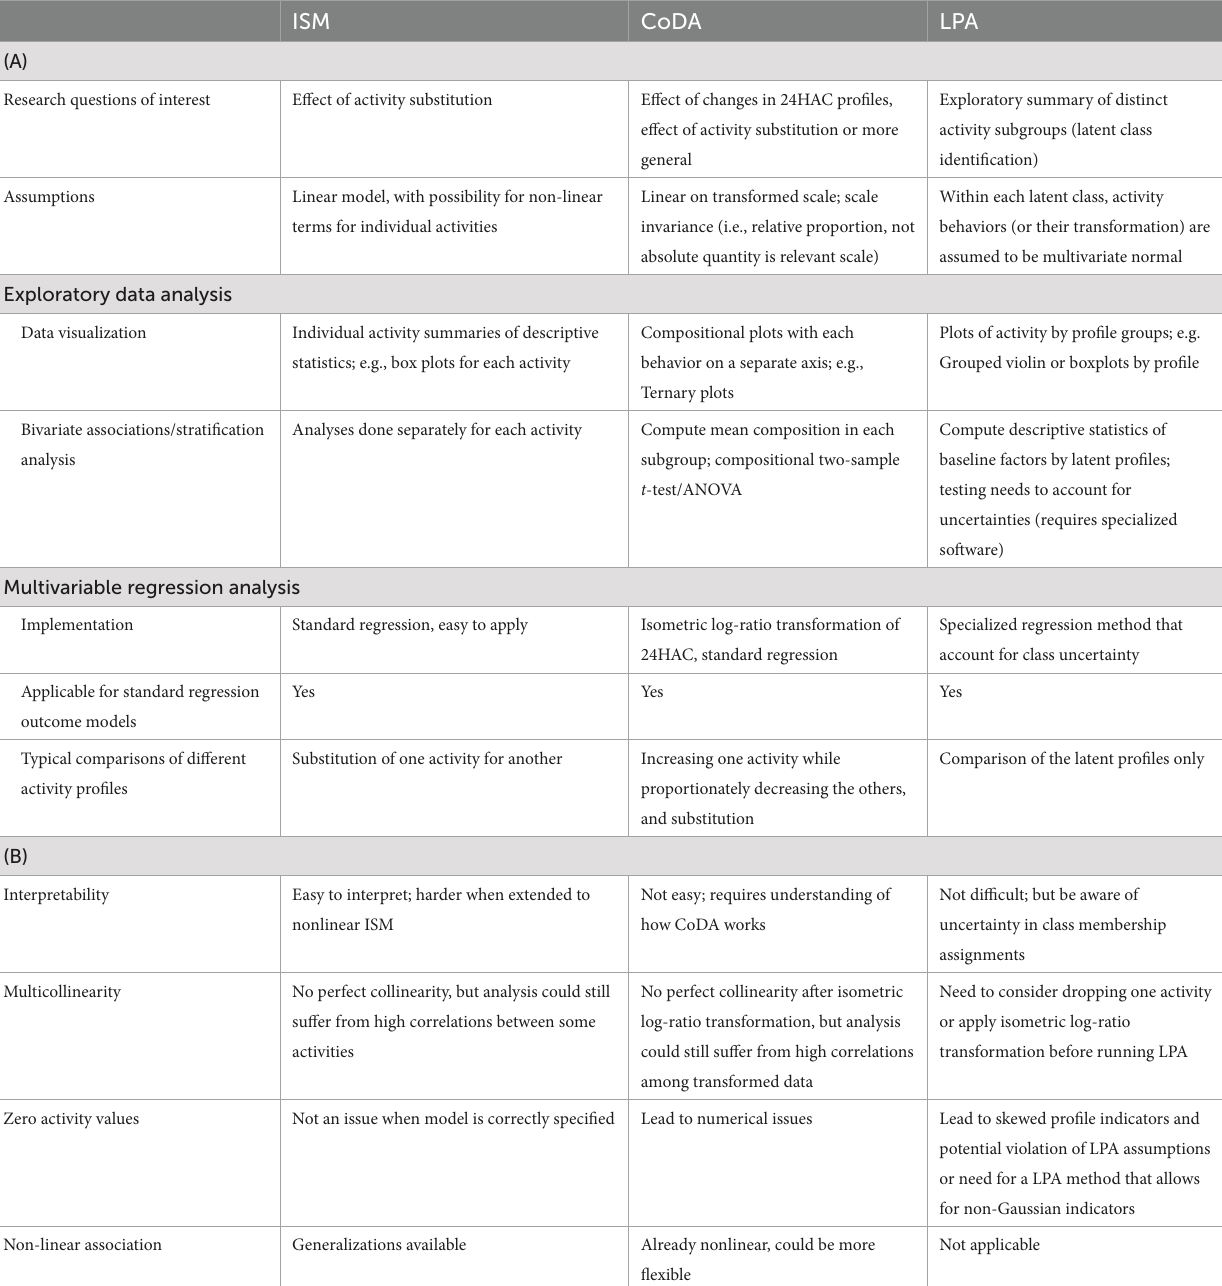
TABLE 6 (A) Comparative summary of three methods to analyze 24HAC: Isotemporal substitution (ISM), Compositional Data Analysis (CoDA), and Latent Profile Analysis (LPA); (B) Statistical features and challenges of three methods to analyze 24HAC: Isotemporal substitution (ISM), Compositional Data Analysis (CoDA), and Latent Profile Analysis